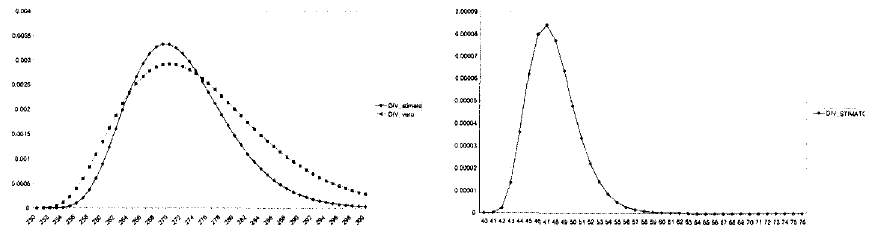
Figure 3 - Estimated md true DV1 profileu. Pipm i - Estimated DV1 profile for the